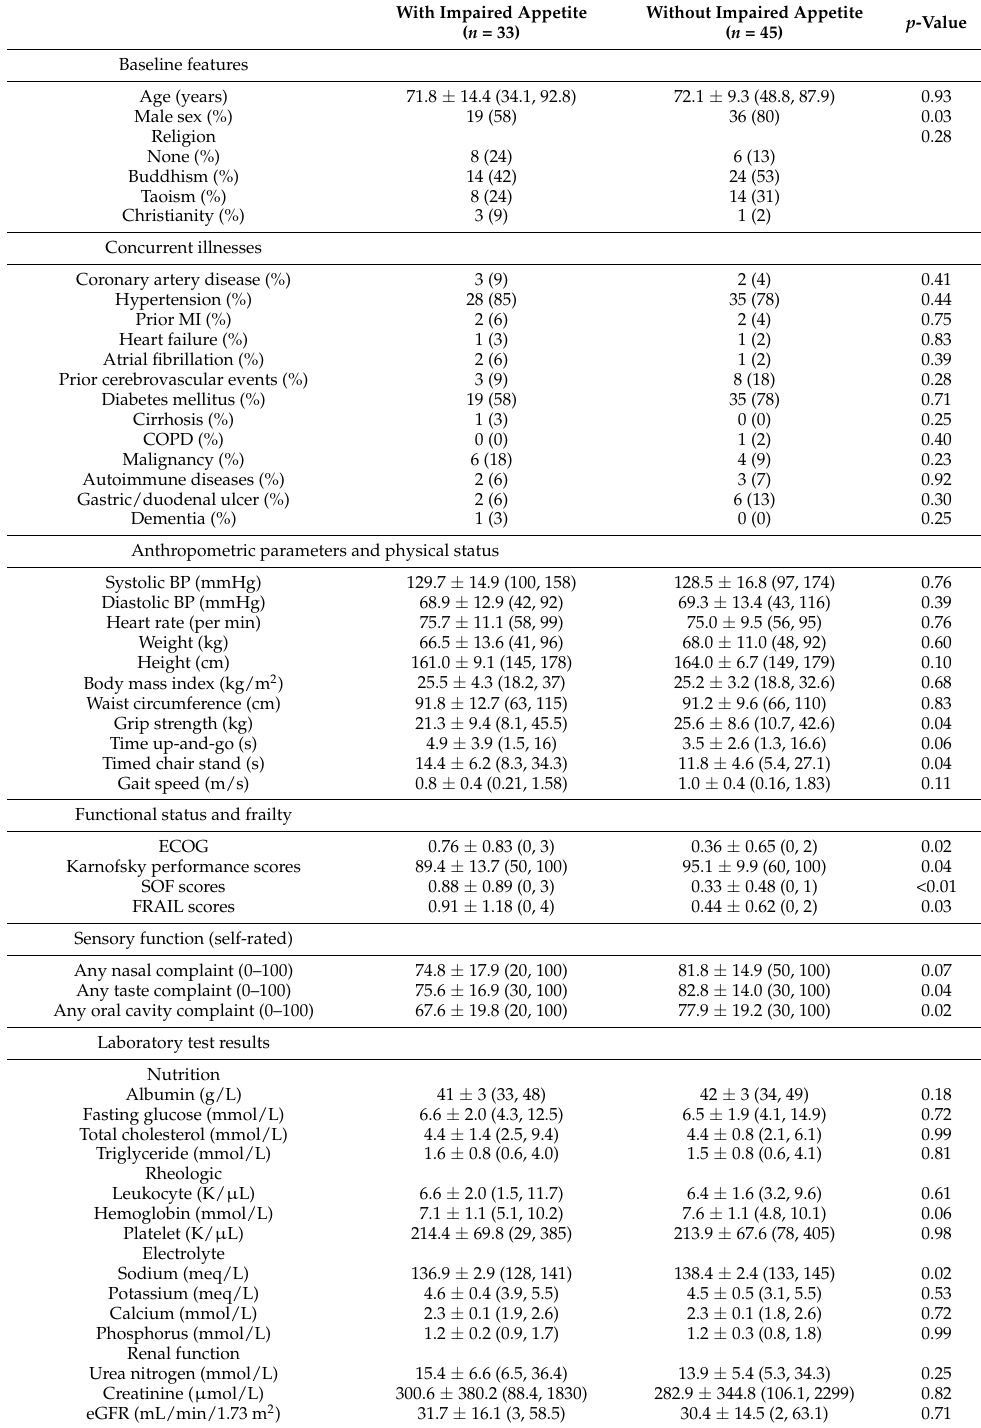
Table 1. Characteristics of patients with chronic kidney disease with and without an impaired